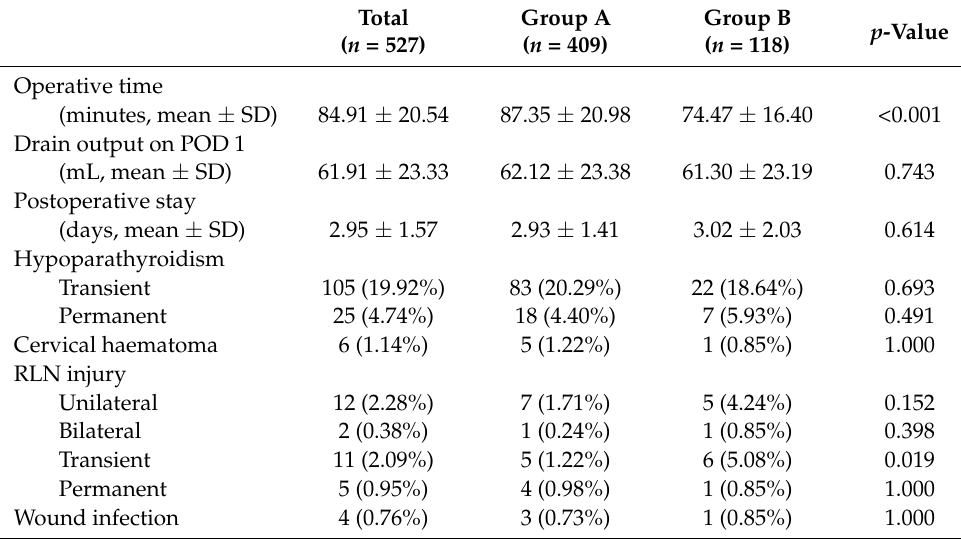
Table 2. Surgical outcomes and